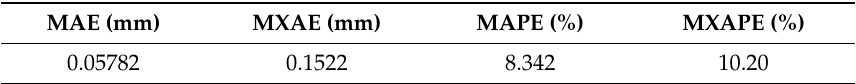
Figure 3. Normalized ANN predictions vs. target output neuron values of all test samples. The ANN had the architecture of [3 6 10 67], resulting in MSE of 0.009454 and R 2 = 0.9493. Table 2. Summary of the performance evaluation results of the developed model in Figure 3 in terms of Mean Absolute Error (MAE), Maximum Absolute Error (MXAE), Mean Absolute Percent Error (MAPE), and Maximum Absolute Percent Error